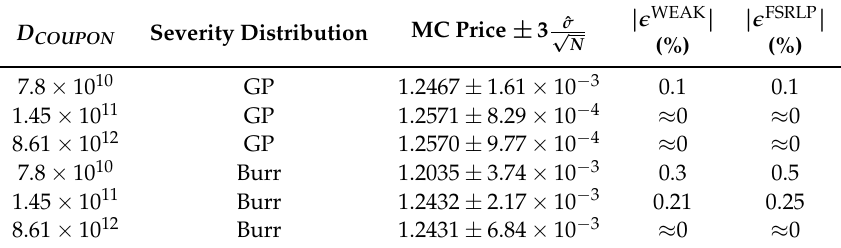
Table 5. Comparison of index-linked CP CAT bond prices, under the weak approximation, MC estimation and the FSRLP approximation, for different threshold levels D COUPON and different underlying loss severity